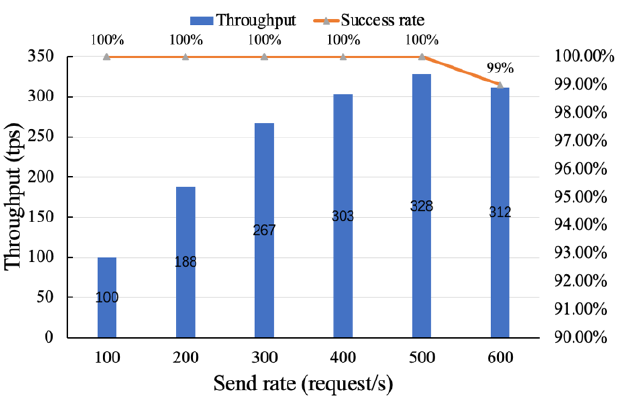
Figure 10. Throughput performance and transaction success rate of the traceability function.